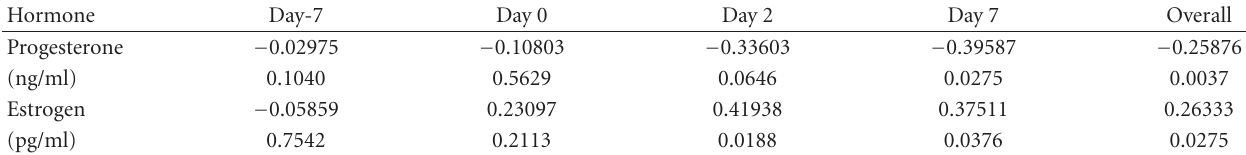
Table 4: Pearson correlation coe ffi cients: days to ovulation X hormone concentration by day (correlation value/ P -value). Hormone Day-7